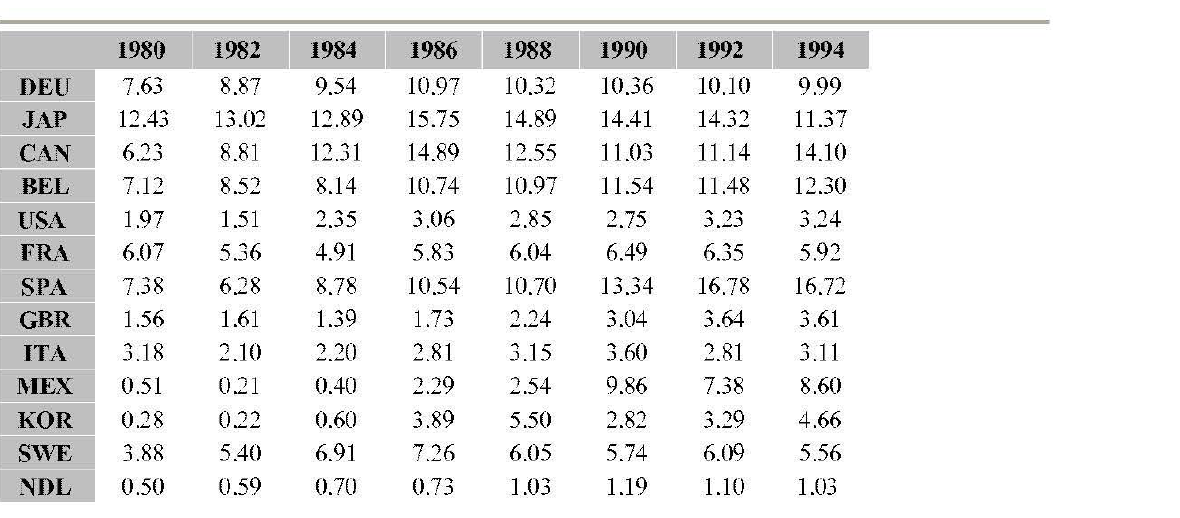
Table 2:Car Exports as the Share of Total Exports of Selected Countries